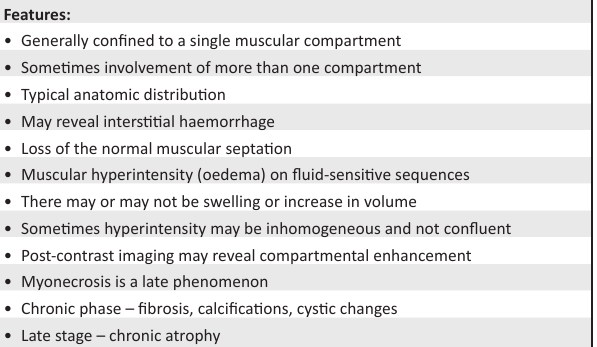
BOX 5: The magnetic resonance imaging features of upper limb compartment